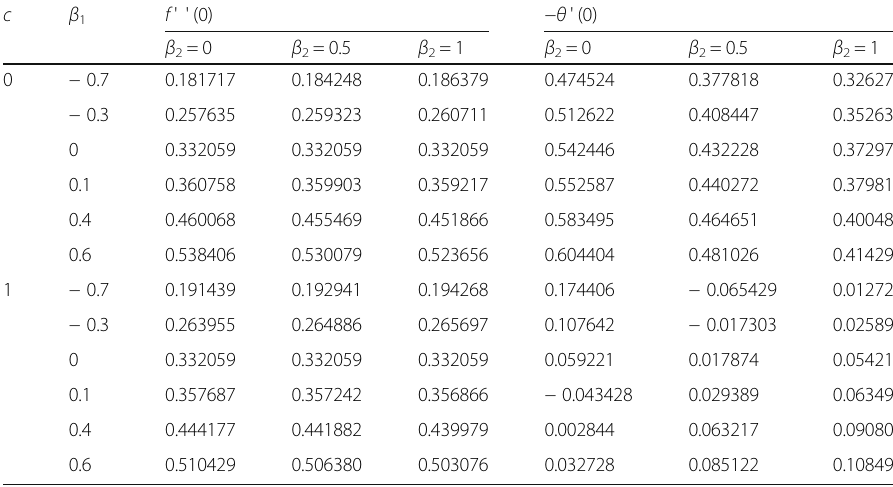
Table 1 Skin friction coefficient f ' ' (0), wall temperature gradient for different values β 1 , and β 2 with and without